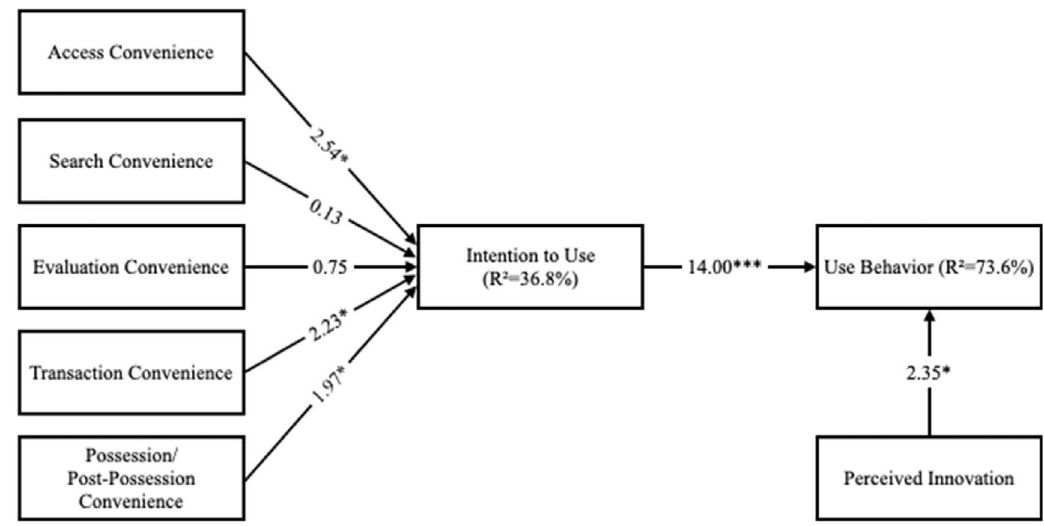
Fig. 2. Model analysis